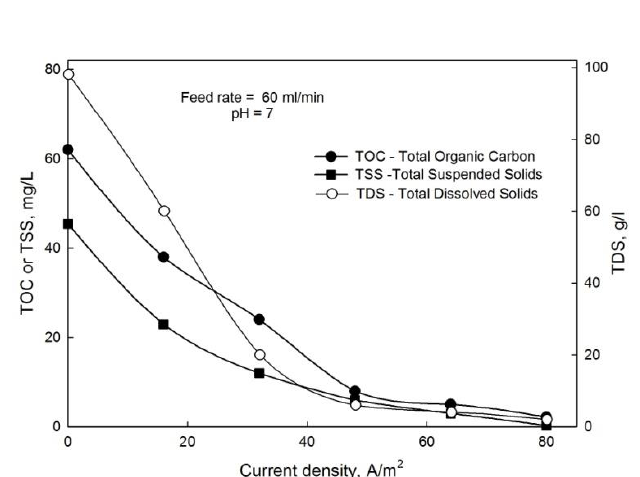
Figure 8. Effect of current density on residual constituents.